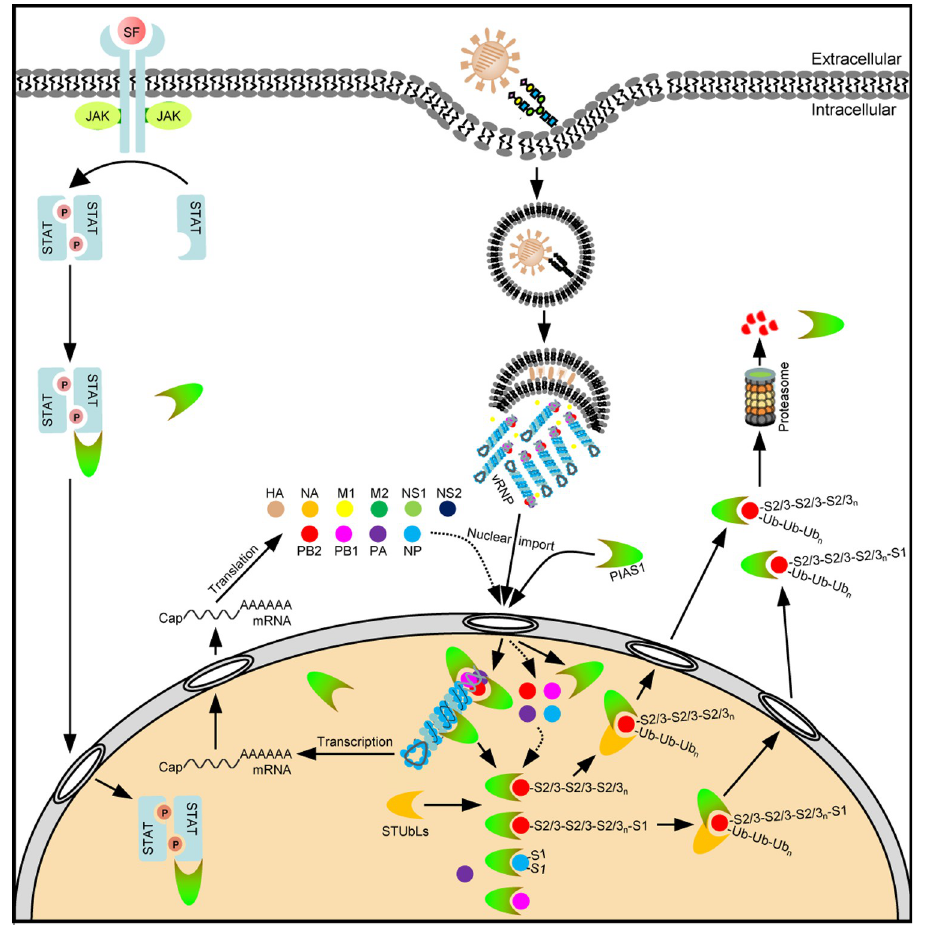
Fig 10. Schematic model of PIAS1-mediated SUMOylation and degradation of IAV PB2. Upon initial binding with sialic acid receptors on the cell surface, IAV is endocytosed into host cells. Following low-pH mediated fusion of viral and endosomal membranes, the vRNPs are released into the cytoplasm, and translocate into the nucleus where they catalyze the transcription and replication of viral genome. PIAS1 mediates robust poly-SUMOylation of PB2 from incoming vRNPs or newly synthesized PB2 by SUMO1/2/3, and also catalyzes minimal SUMOylation of NP by SUMO1. PIAS1-mediated SUMOylation of PB2 most likely recruits SUMO-targeted ubiquitin ligases (STUbLs) to the SUMOylated PB2, resulting in ubiquitination-dependent proteasomal degradation of PB2. SF: stimulating